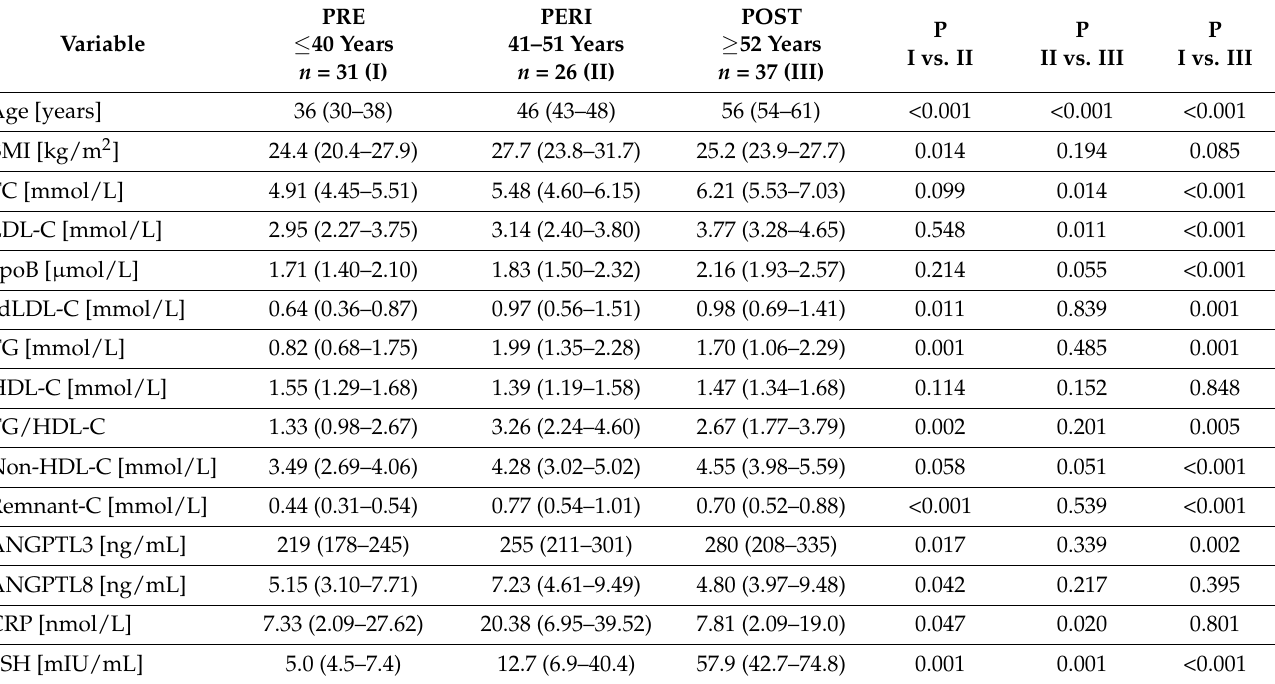
Table 1. Characteristics of study participants dependent on menopausal status.